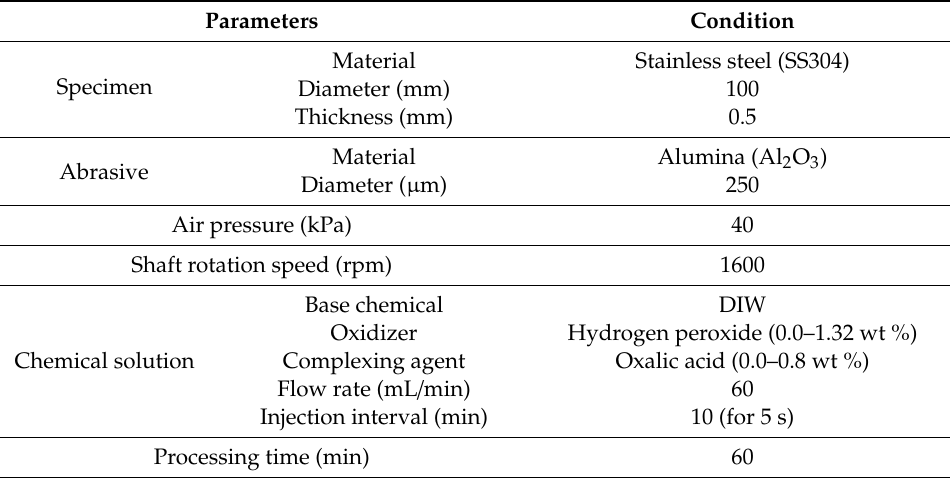
Figure 3. Schematic of fluidized bed chemical mechanical polishing system. Table 1. Experimental conditions.